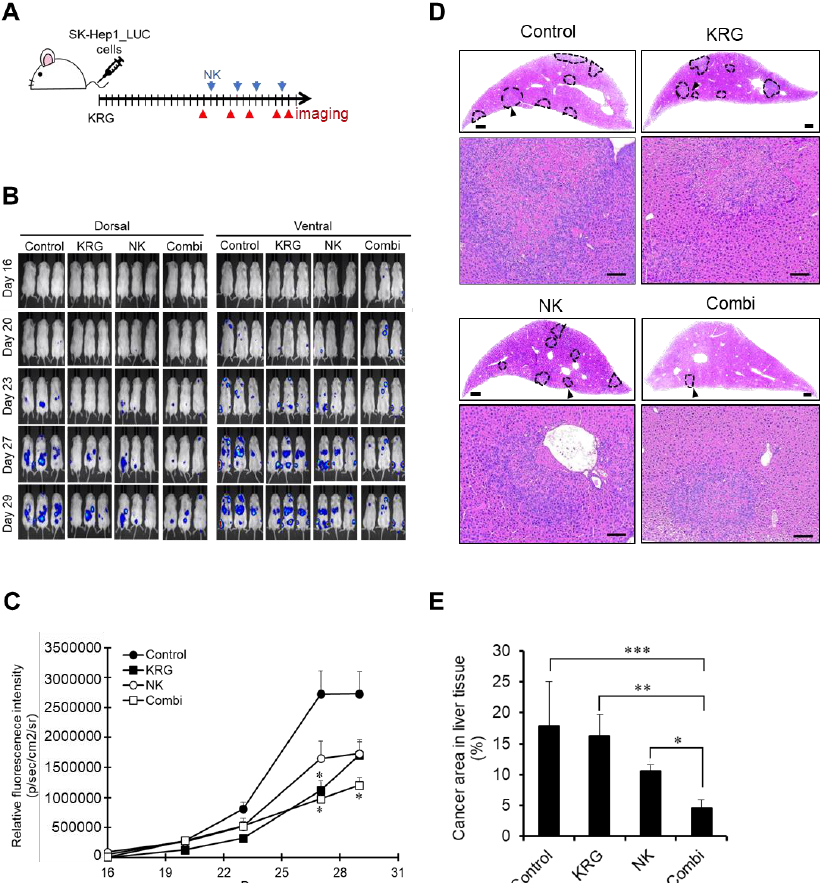
Figure 1. Anti-metastatic effect of KRG and NK cells. ( A ). Schedule of treatment and in vivo imaging in metastasis model ( n = 3/group). ( B ). In vivo imaging of SK-Hep1 metastasis. The in vivo bioluminescence imaging was conducted on days 16, 20, 23, 27, and 29. Images are representative of twice replicated experiments. ( C ). In vivo bioluminescence intensity. Data obtained from B are expressed as the mean ± SD ( n = 3/group). *, p < 0.05 (one-way ANOVA with a Dunnett’s post hoc test). ( D ). Hematoxylin staining of liver tissues. Dashed lines indicate metastatic lesions. Scale bar, 500 µ m (Upper panel). Magnified pictures of the arrow point are shown in the lower panel. Scale bar, 100 nm. ( E ). Area of metastatic lesions in liver tissues. Data are expressed as the mean ± SD (two slides of liver tissue from each mouse, n = 3/group). *, p < 0.05; **, p < 0.01; ***, p < 0.005. (two-way ANOVA with a Tukey’s post hoc